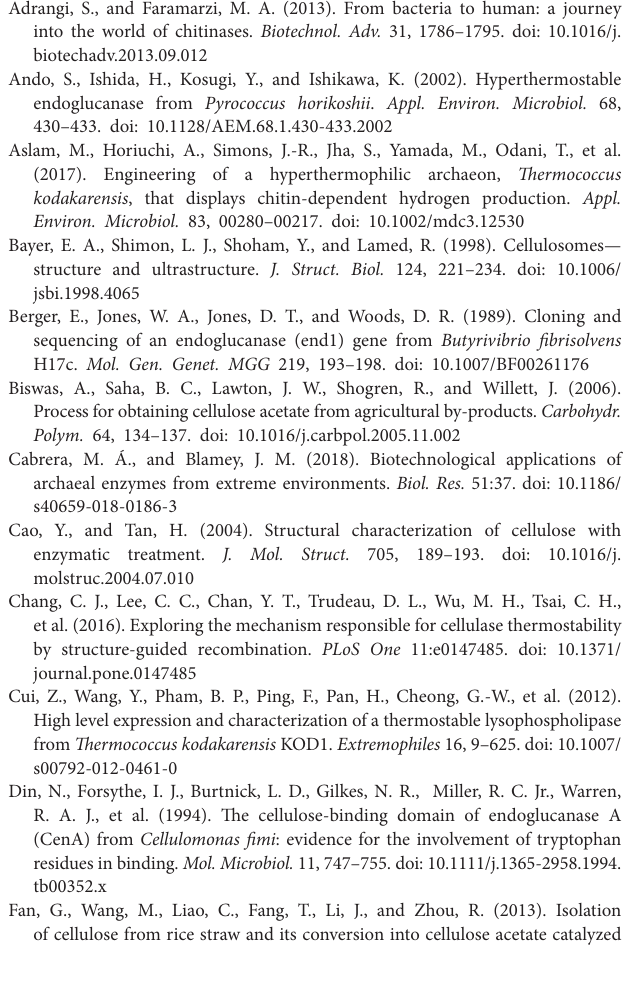
( Table 4, Figure 5 ). Using the optimized reaction parameters reported here, Tk-ChiA could be utilized for cost-efficient rice straw degradation in industrial applications. In conclusion, the thermostable enzyme Tk-ChiA has dual